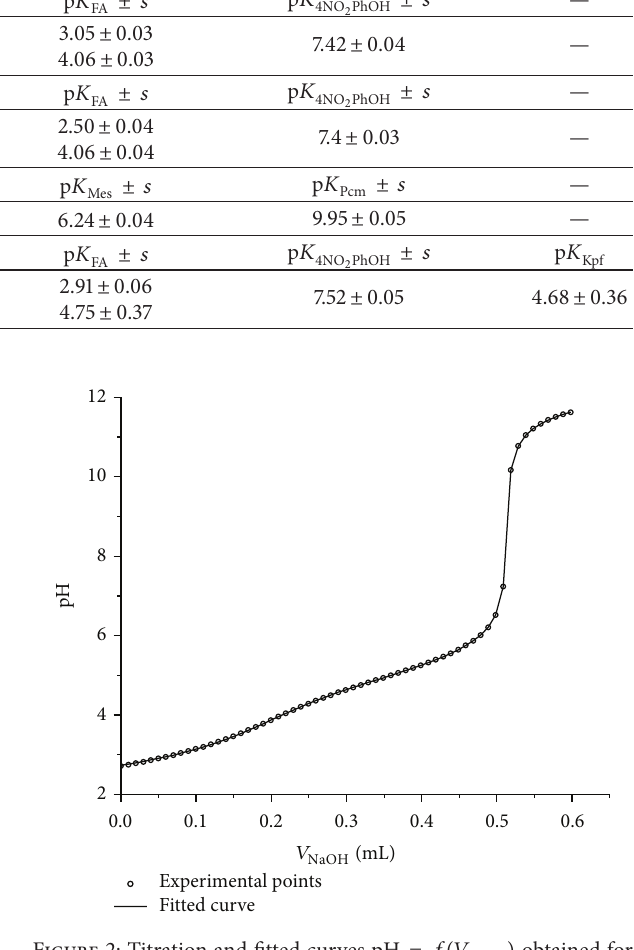
Figure 2: Titration and fitted curves pH = 𝑓(𝑉 mixture of PhA, Py-4CA, and MA with mole ratio of acids 1 :2